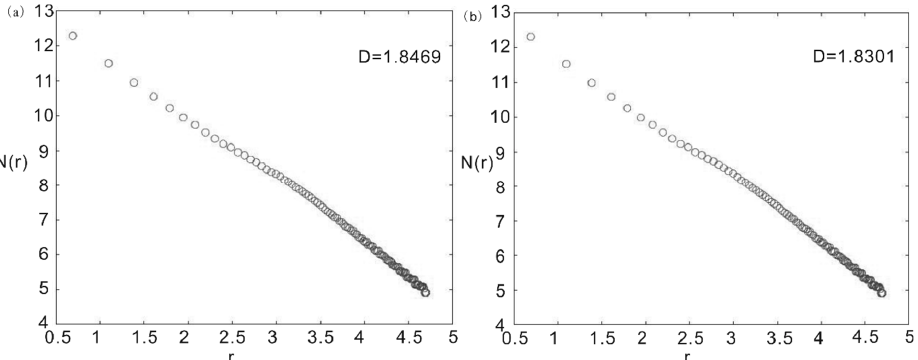
Figure 9. Calculated fractional dimensions. ( a ) Fractional dimension of S7-12; ( b ) fractional dimension of S7-16.